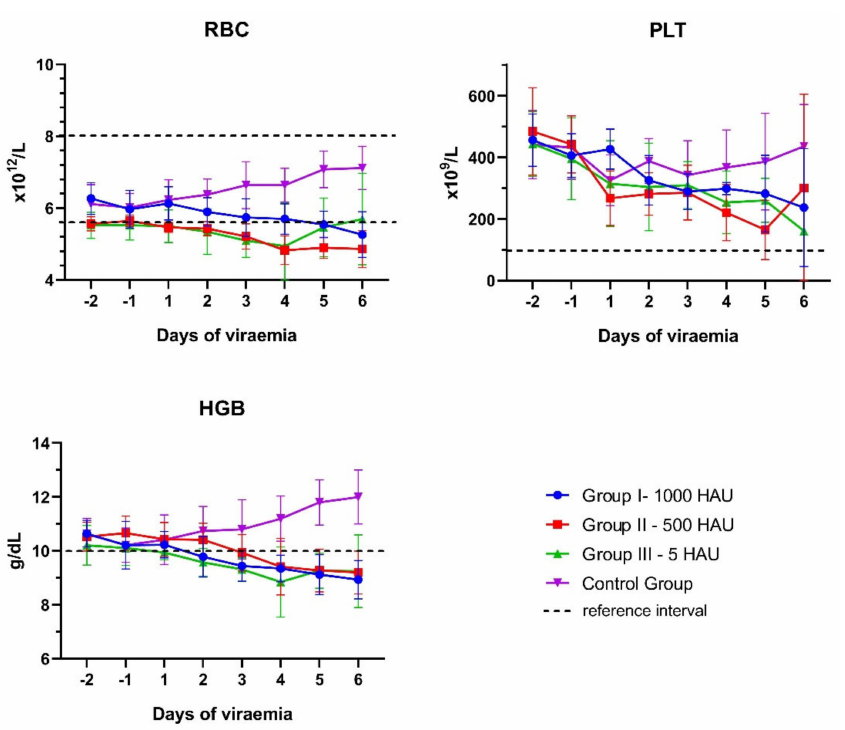
Figure 2. Mean values of red blood cell number (RBC), platelet number (PLT), and hemoglobin concentration (HGB) observed during the African swine fever virus (ASFV) infection. For HGB and PLT, only a low reference threshold is presented. Error bars indicate standard deviation.